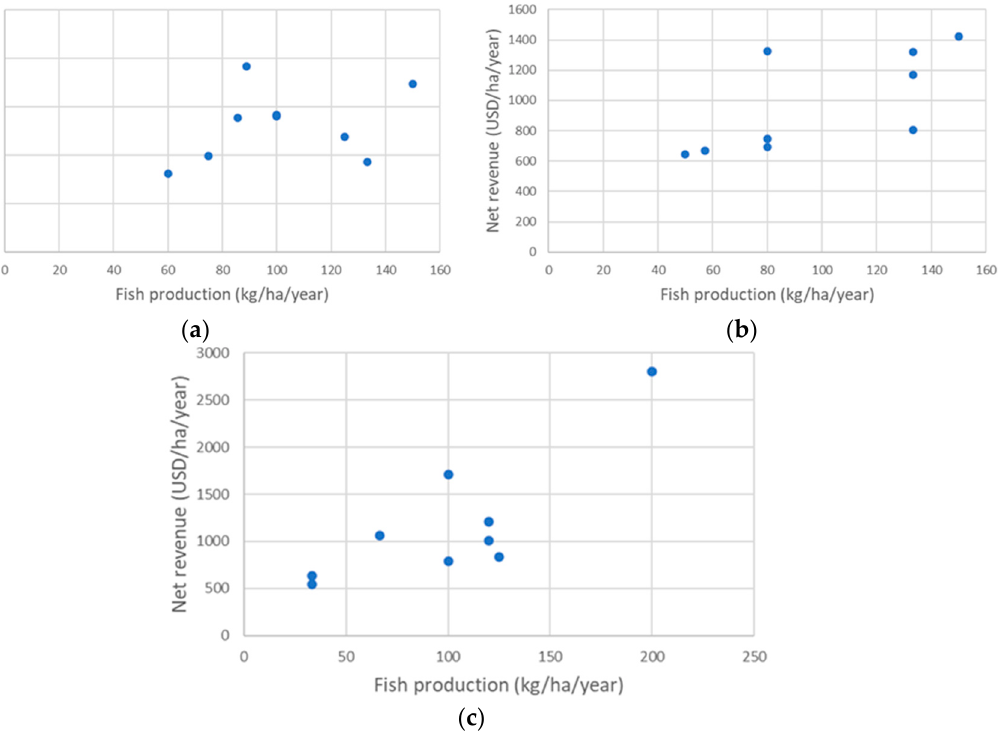
Figure 6. Scatter plot of the relationship between fish production and net revenue from mangrove-fish pond with ( a ) high mangrove cover ( b ) medium mangrove cover and ( c ) low mangrove